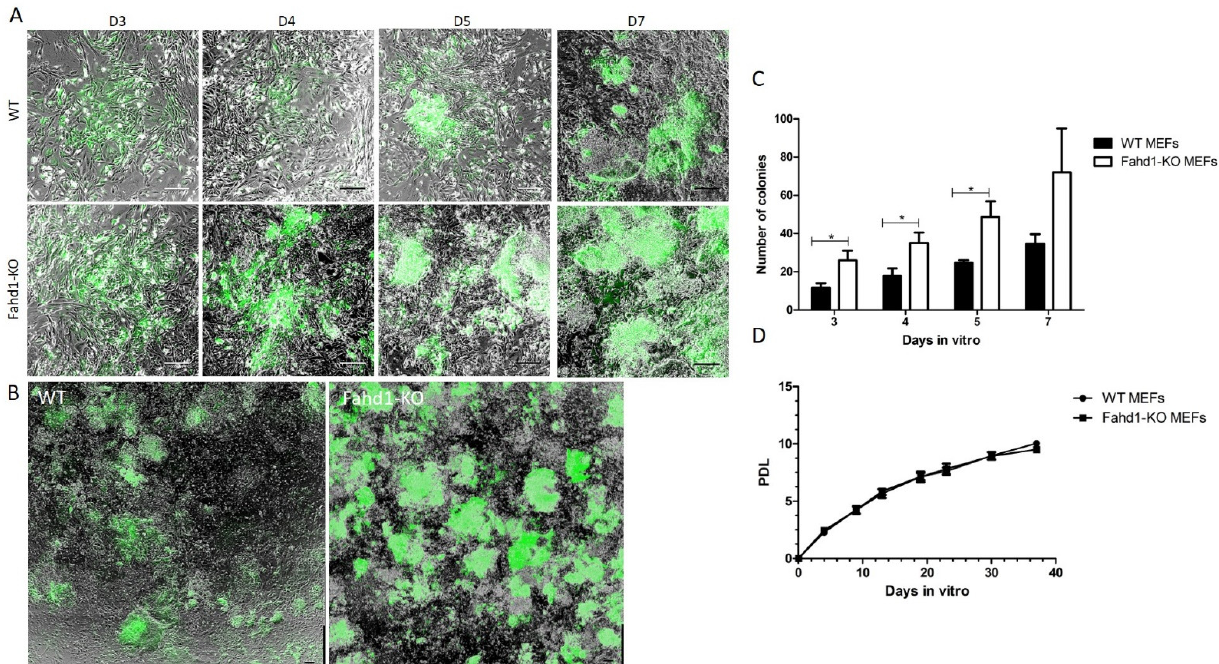
Figure 1. Increased iPSC-like colony formation in Fahd1-KO MEFs during reprogramming. ( A ) Merged phase-contrast and fluorescent images showing the difference in the fluorescent colony formation during the course of reprogramming from day 3 (D3) to D7 of WT and Fahd1-KO MEFs. ( B ) Merged tile scan images of phase contrast and fluorescent images covering most of the surface of a well of WT and Fahd1-KO reprogrammed MEFs, respectively, at D7. ( C ) Counting the fluorescent and non-fluorescent iPSC-like colonies at 3, 4, 5, and 7 days in vitro shows a clear and significant increase in the number of colonies formatted in Fahd1-KO as compared to WT, * p < 0.05, n = 3. ( D ) Growth curve comparison between WT and Fahd1-KO MEFs for 37 days in vitro. No significant difference was observed. MEFs: mouse embryonic fibroblasts,